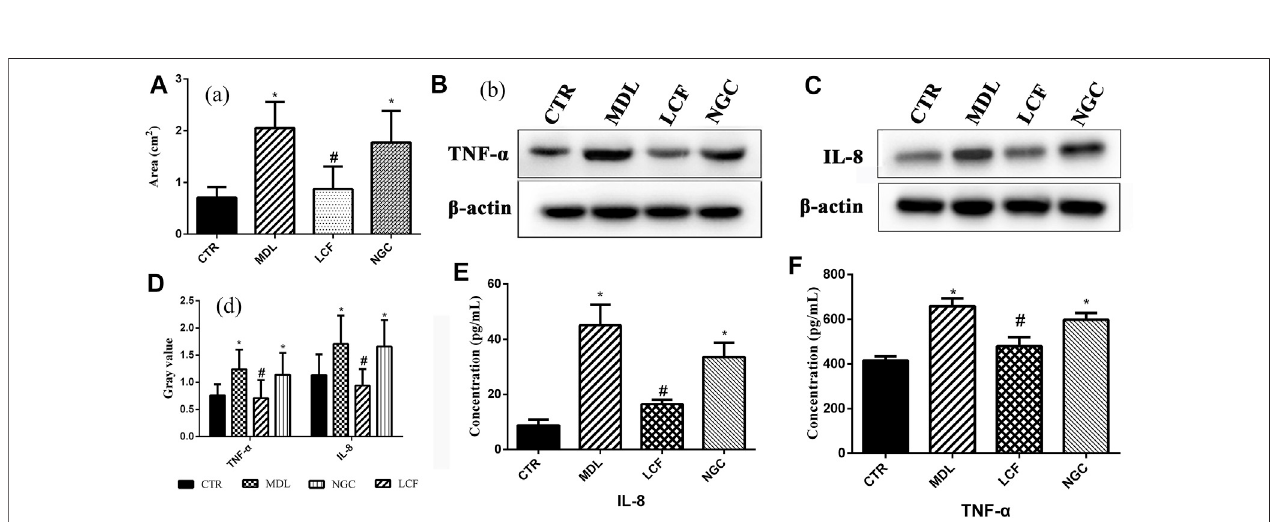
FIGURE2| Pharmacodynamicanalysisoflicorice fl avonoid gelanti-acne; Histologicalanalysis: (A) Areaofthestrati fi edsquamousepithelium;Areaofthestrati fi ed squamous epithelium; Western blot of skin protein: (B) TNF- α , (C) IL-8, (D) Gray values of TNF- α and IL-8; (E,F) Serum concentration of TNF- α and IL-8.